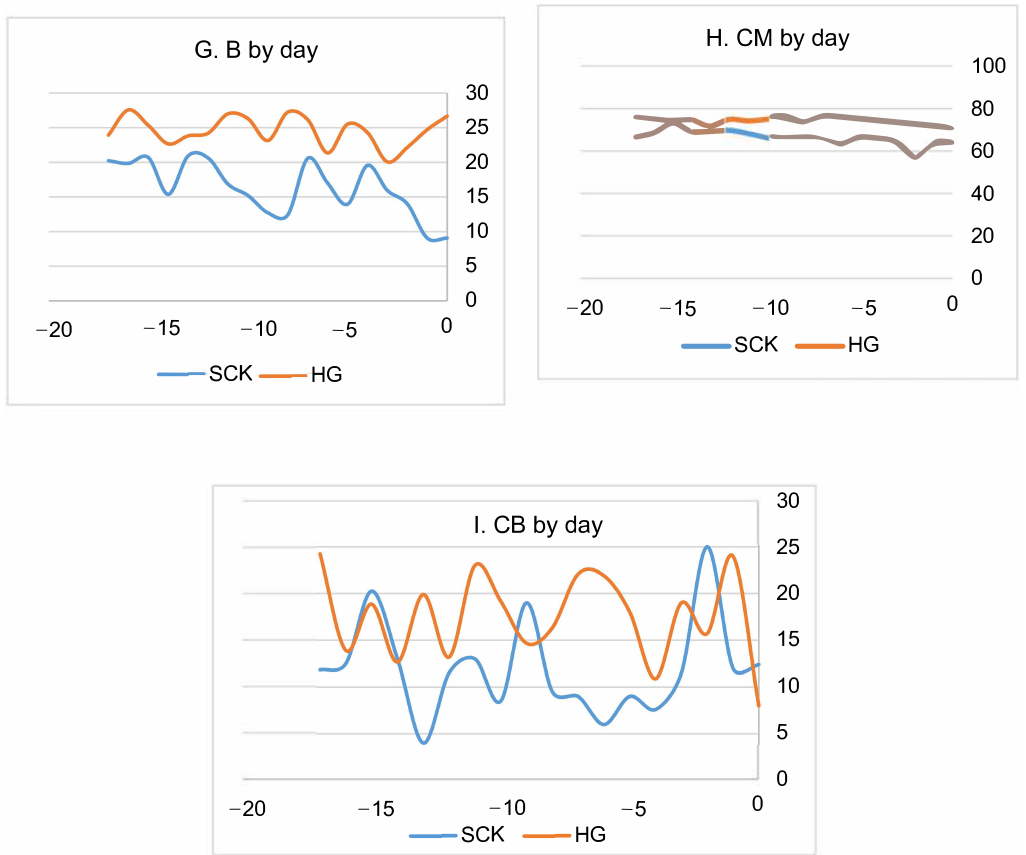
Figure 1. Results of RumiWatch noseband sensor readings. Values are the means of 10 SCK and HG dairy cows observed in summer 2020 in Lithuania. RT—Rumination time (time in minutes spent